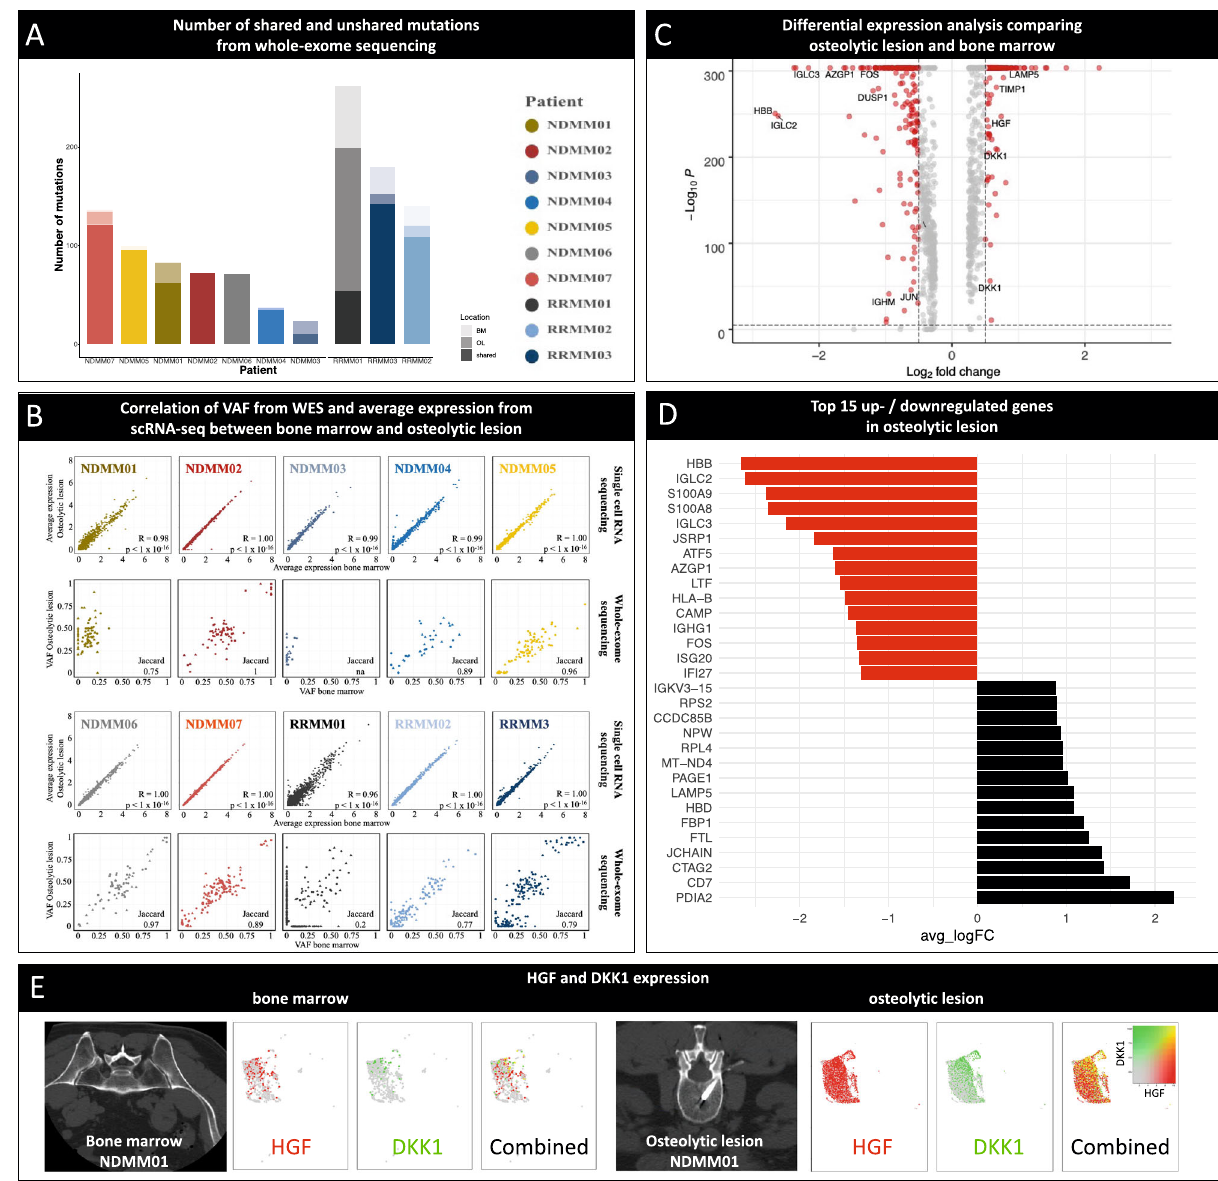
Fig. 5 Limited evidence for spatial heterogeneity from whole-exome sequencing and signi fi cant correlation of gene expression from plasma cells from bone marrow and osteolytic lesion. A Bar plots showing the number of shared and unshared mutations from whole-exome sequencing (WES) for each individual patient (bone marrow/BM = light colors, osteolytic lesion/OL = medium colors, shared = dark colors). Patients with relapsed/refractory multiple myeloma (RRMM) harbored more mutations compared to newly diagnosed disease (NDMM). B First and third rows: Scatter plots for average gene expression from single cell RNA sequencing. Second and fourth rows: Variant allele frequency (VAF) from WES. Results from plasma cells (PC) from the bone marrow (BM) are plotted to x-axis and from the osteolytic lesion (OL) to the y-axis for each individual patient. Jaccard indices were calculated to quantify the overlap between both samples based on WES. In WES scatter plots, effects of the mutations are delineated by different symbols (altering = circle, non-amino acid change = triangle, truncating = square). Only in patient RRMM01 with para-medullary disease (PMD), we found substantial differences as indicated by a Jaccard score of 0.2. Also average gene expression of PC from both location was highly correlated to each other as indicated by two-sided Spearman ’ s correlation coef fi cients. Nevertheless, outliers in both directions could be detected with scRNA-seq. C Differential expression analysis comparing OL and BM identi fi ed 1140 signi fi cantly up- and downregulated genes in PC from OL. While genes that have been associated with myeloma bone disease were upregulated (e.g., DKK1 , HGF, and TIMP1 ) in OL, JUN/FOS , DUSP1 and HBB were recurrently downregulated. Log2 fold change between OL and BM plotted on x-axis, p-values (Bonferroni corrected) derived from two-sided Wilcoxon Rank Sum test on y-axis D Top 15 up- and downregulated genes in PC from OL with regards to average log-fold change (avg_logFC). Gene set enrichment analysis demonstrated that genes connected to regular B-cell function were signi fi cantly downregulated in OL (Supplemental Fig. 3). E Comparison of HGF (red) and DKK1 (green) expression in malignant PC from BM (left side of the panel) and OL (right side of the panel) in patient NDMM01. The number of cells expressing both genes (yellow) as well as expression levels were lower in BM compared to